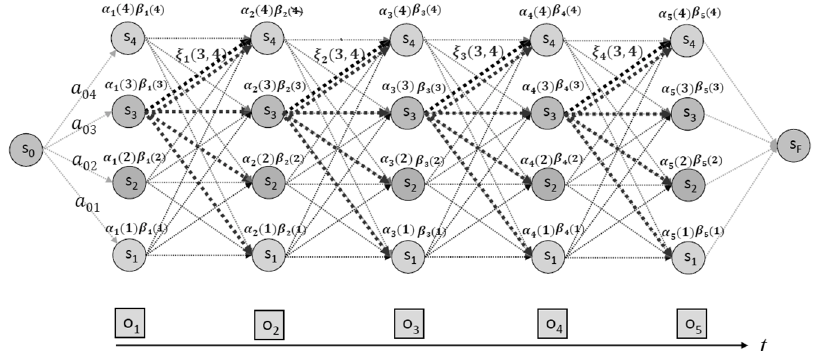
Figure 3 . Forward Probability ( α ) & Backward Probability ( β ).